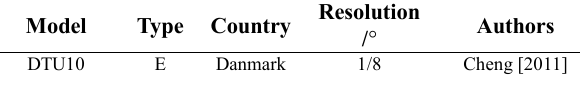
Table 1. Participating Global Ocean Tide